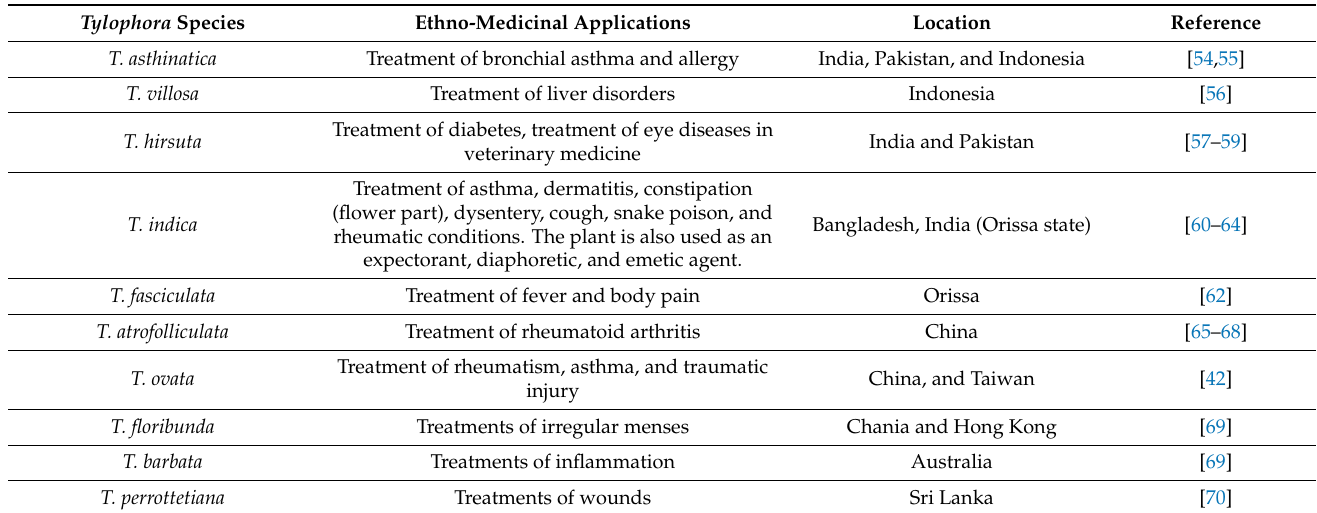
Table 2. Ethno-medicinal uses of genus Tylophora